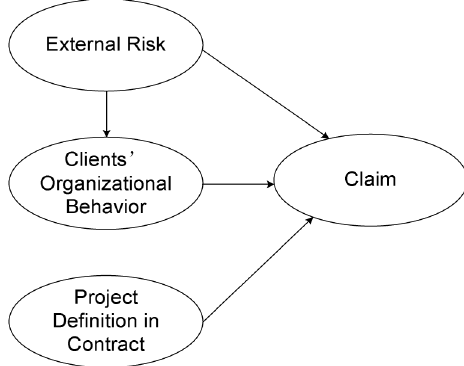
Fig. 1. Conceptual model on causes of contractors’ claims in EPC